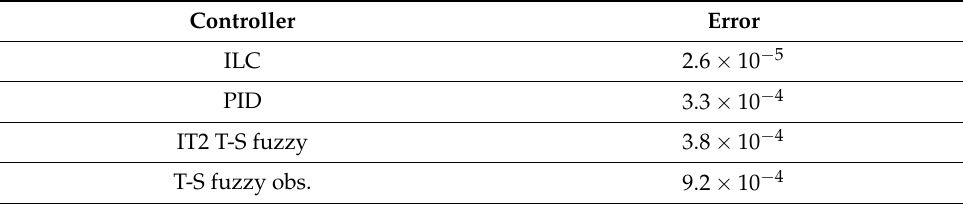
Figure 16. The comparison of the controllers’ performance with respect to the disturbance rejection error. Table 3. Comparison between the controllers’ performance in disturbance